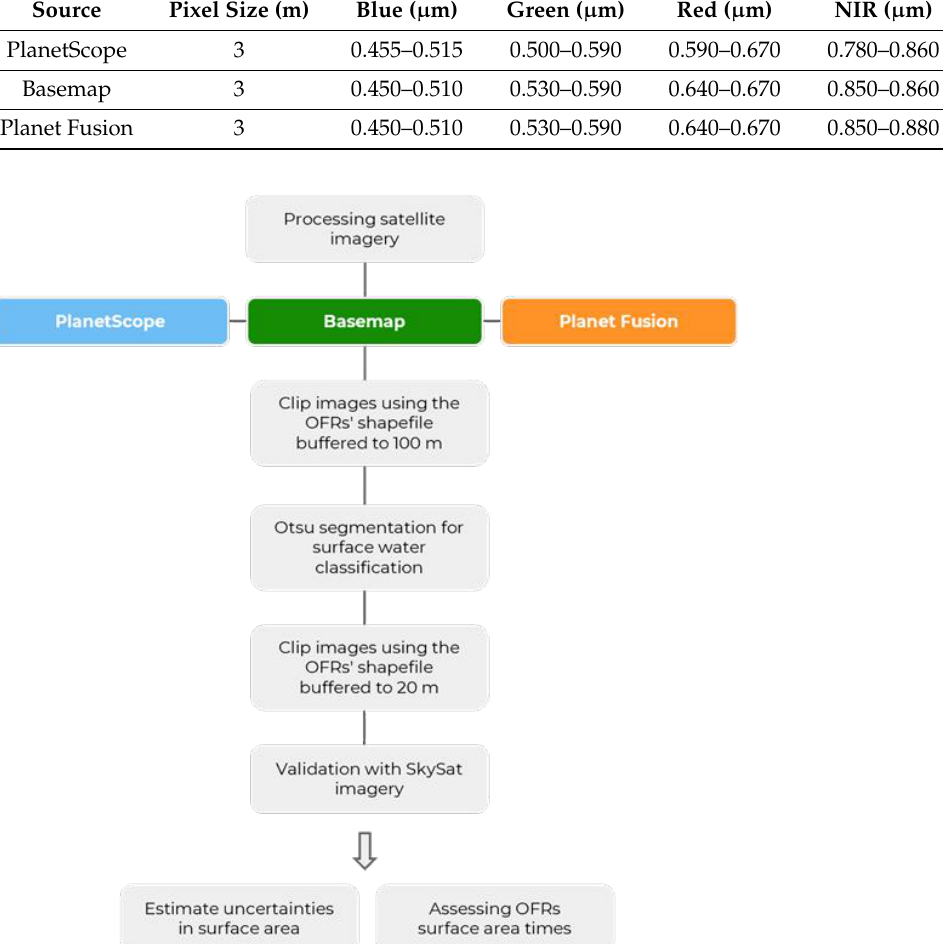
Figure 2. Workflow used to estimate the OFRs’ surface area-time series from PlanetScope, Basemap, and Planet Fusion between July 2020 and July 2021.